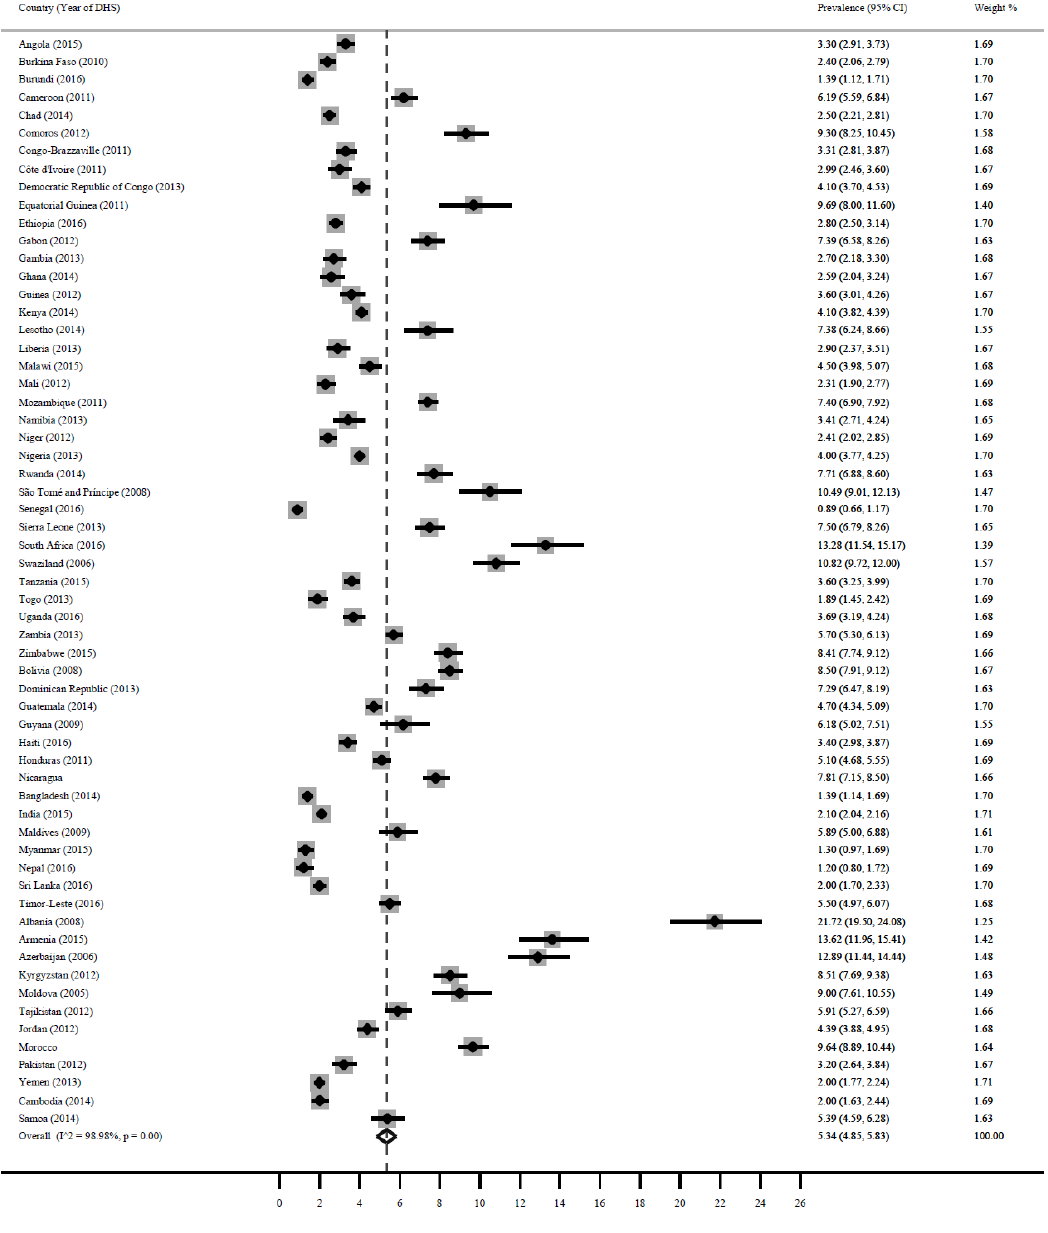
Figure 4. Prevalence of child overweight/obesity in LMICs.